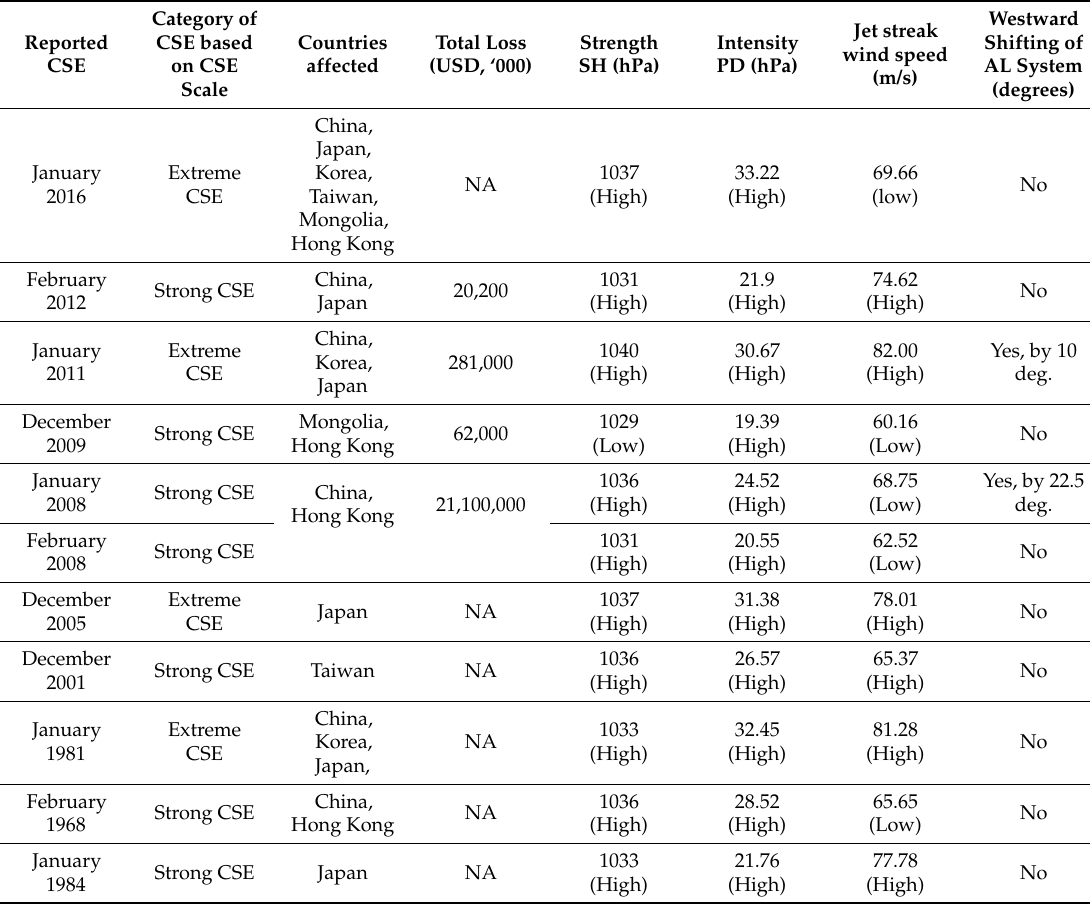
Table 2. Reported CSEs available from the Emergency Events Data Base (EM-DAT), categorized based on the CSE Scale of Table 1. High and low values in parentheses indicate value above and below the climatological mean. In the table ‘NA’ refers to data not